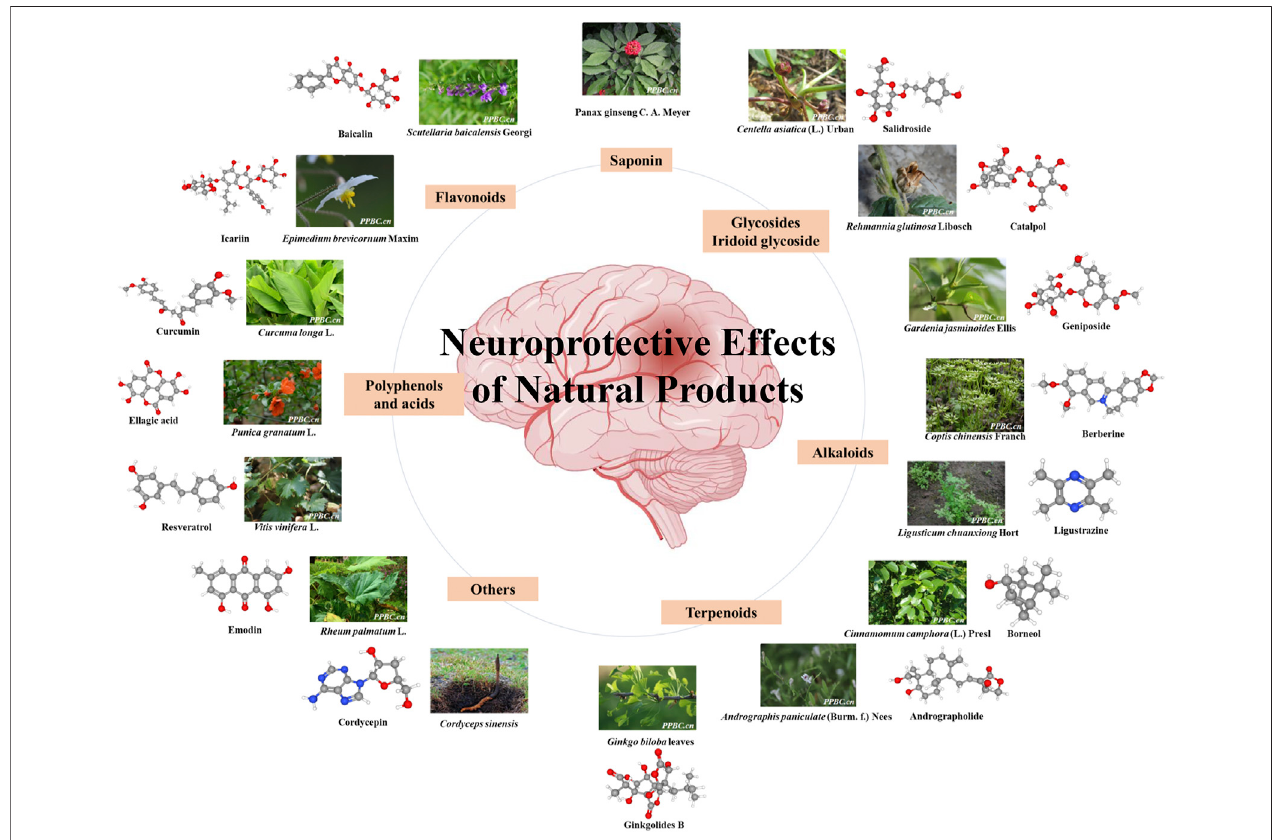
FIGURE 1 | Neuroprotective effect of various natural products. The color fi gures of medicine are viewed in www.iplant.cn. The club model comes from PubChem.